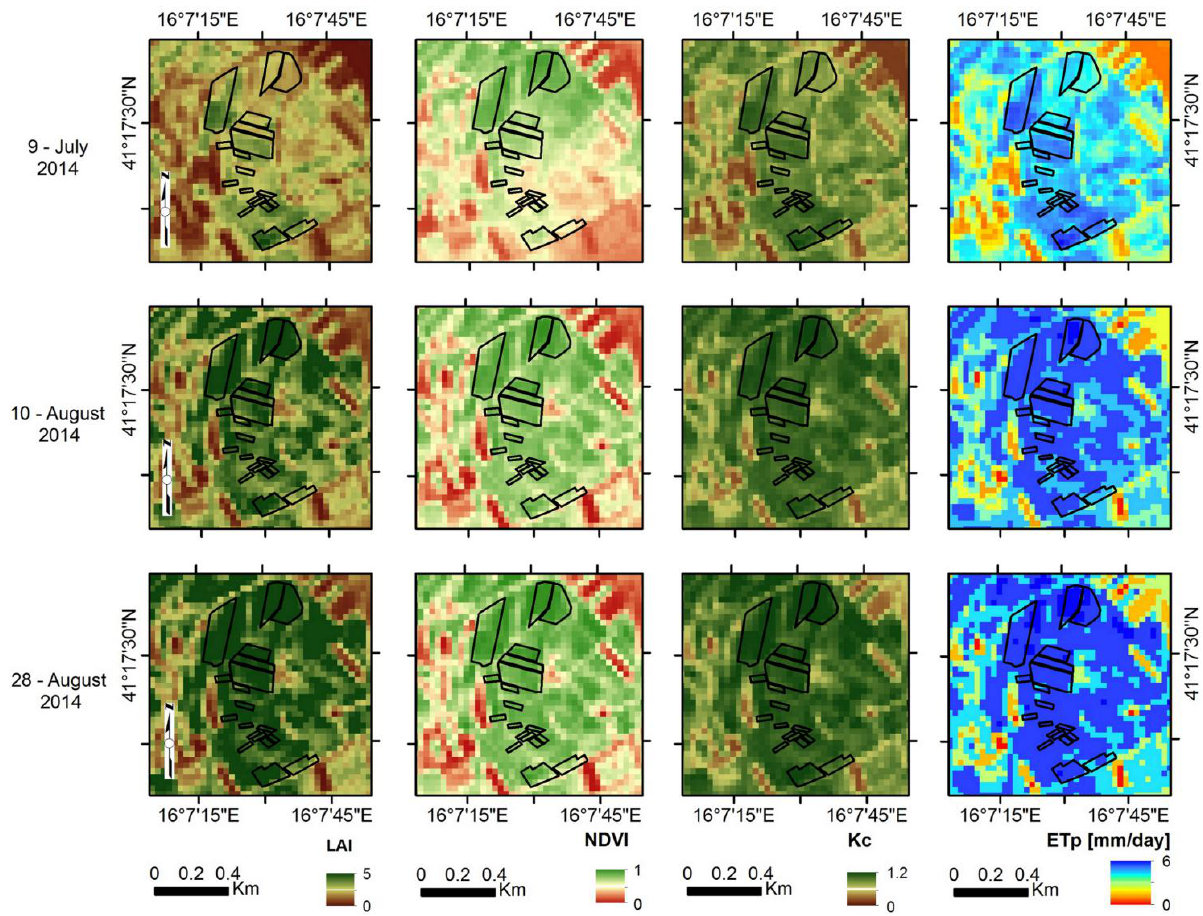
Figure 9. An example of time-series maps of LAI, NDVI, K c , and ET p for the vineyard study field represented in Figure